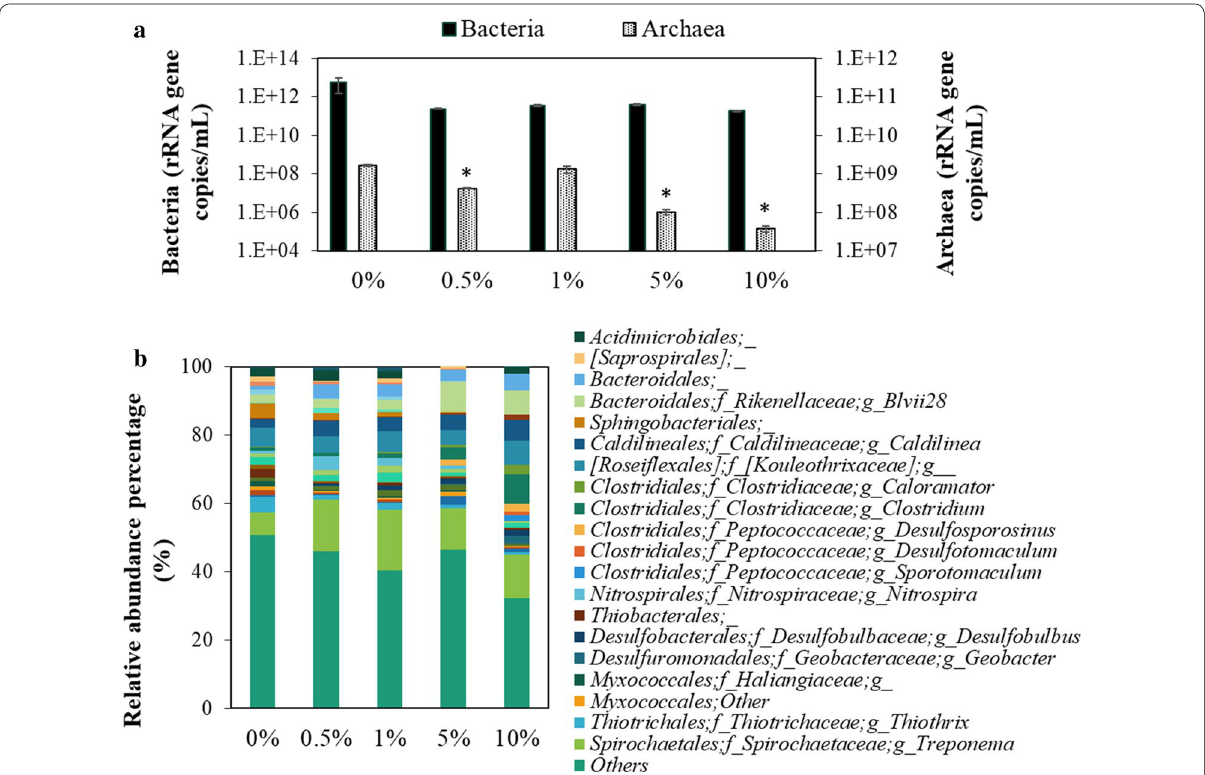
Fig. 4 Impact of Aso limonite to bacterial/archaeal activities and bacterial community in WSS at the end of anaerobic digestion process; a proportion of active bacteria and archaea determined by the quantitative real‑time PCR and b relative abundant percentages of dominant bacterial community indicated by Order, Family, and Genus level (if available). Error bars indicate standard errors (n difference by the addition of Aso